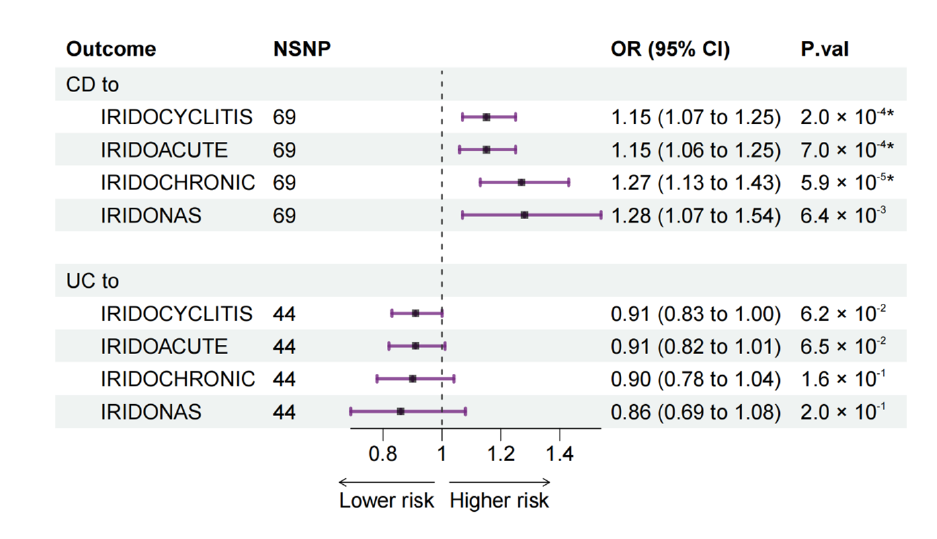
Figure 4. MR estimates from UC and CD to IC in MVMR. MR: Mendelian randomization; UC: ul- cerative colitis; CD: Crohn’s disease; IC: iridocyclitis; MVMR: multivariable Mendelian randomiza- tion; NSNP: number of single nucleotide polymorphism; OR: odds ratio; CI: confidence interval; IRIDOCYCLITIS: IC as a whole; IRIDOACUTE: acute and subacute IC; IRIDOCHRONIC: chronic IC; IRIDONAS: other and unspecified IC. *: p -values of statistical significance (<0.0063) after Bonferroni